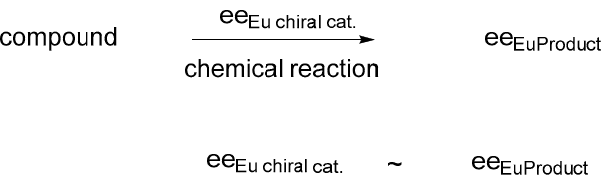
Figure 4. The effect of the chiral catalyst on the enantiomeric purity of the product.